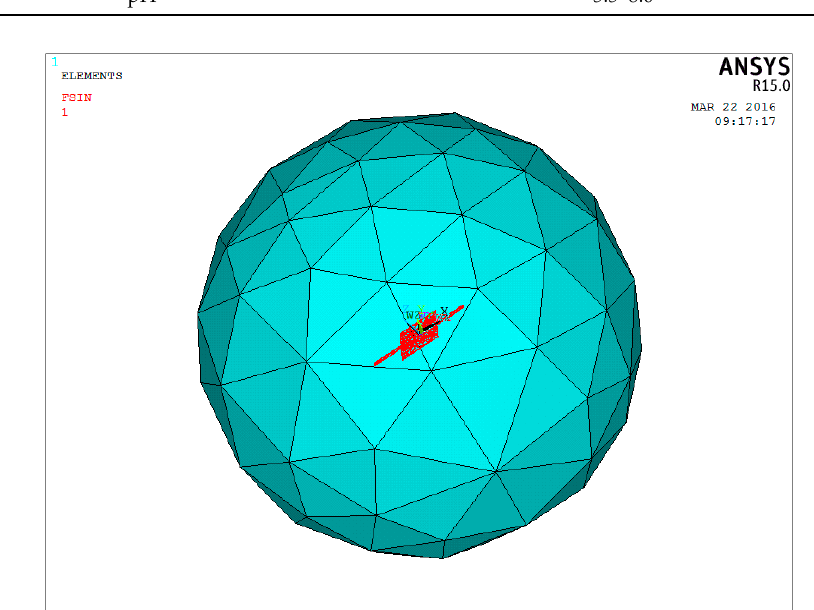
Figure 5. Coupling model.